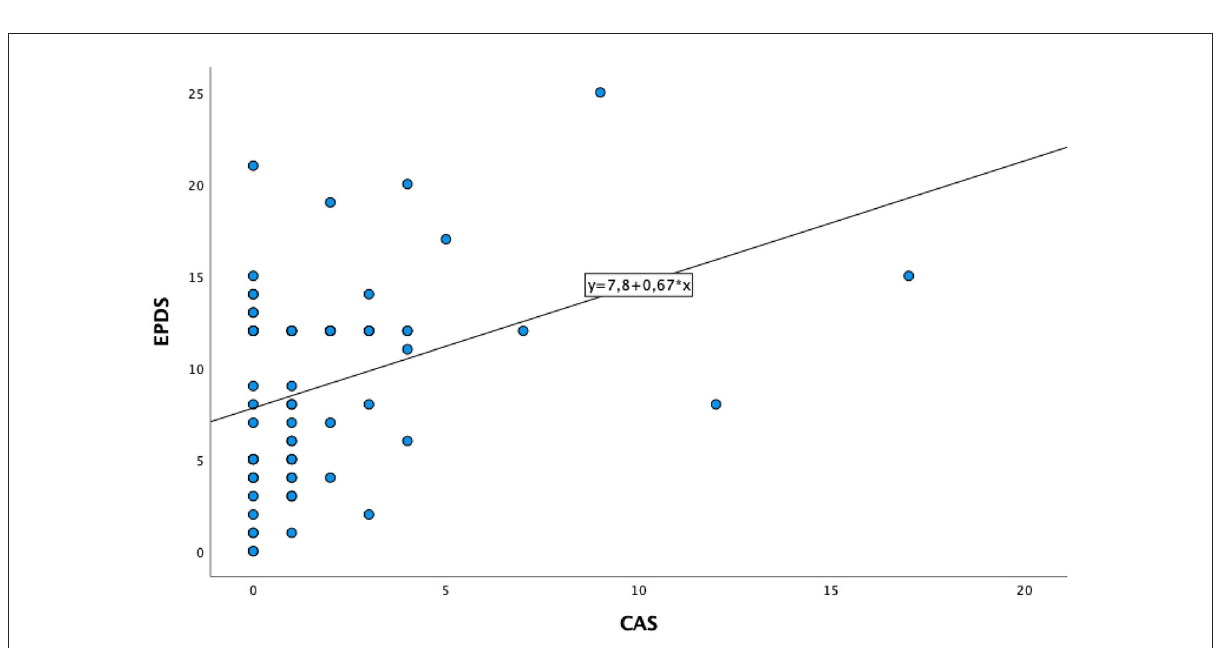
FIGURE2 Linear regression model between CAS and